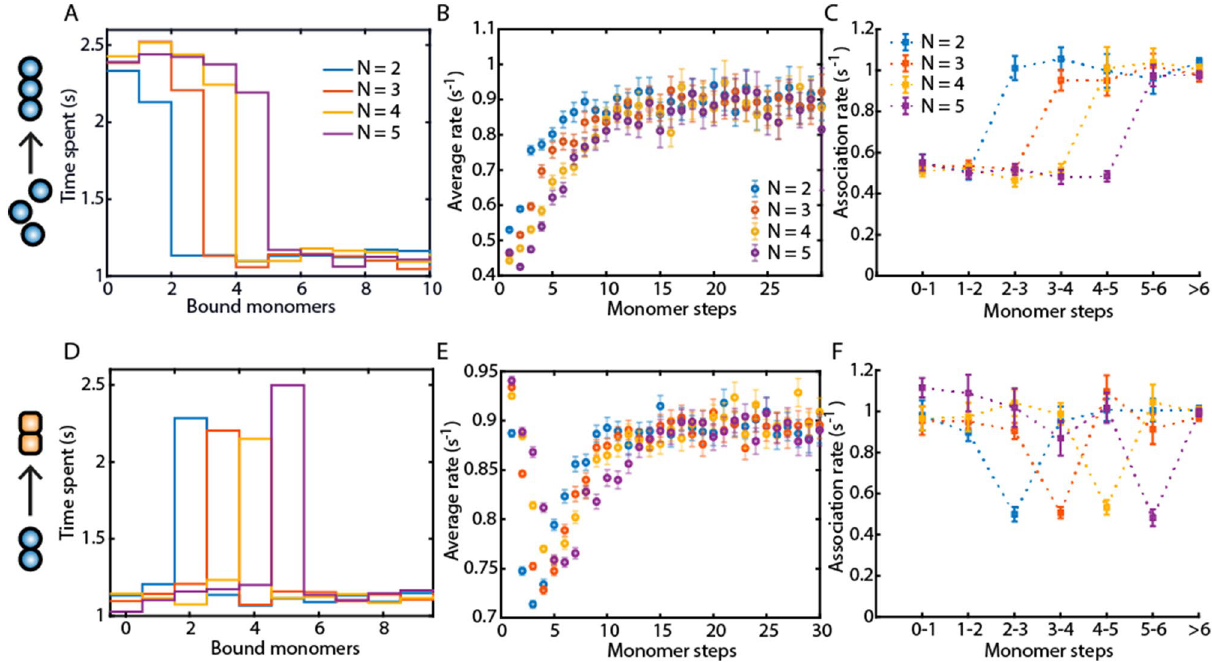
Figure 2. A comparison of the visitation analysis, average rates and dwell-time analysis on an assembly process with nucleus or conversion step with a size of 2, 3, 4 or 5 monomers. ( A , D ): A visitation analysis on a nucleation ( A ) and on a conversion mechanism ( D ). ( B , E ): Average rate analysis on the same nucleation ( B ) and conversion mechanism ( E ) as in ( A , D ) . ( C , F ): Dwell-time analysis on the same nucleation and conversion mechanism as in ( A , D ). The dwell-time analysis can identify a mechanism with a change in the on-rate by extracting the association rates ( C, F ), but not a mechanism with a change in the off-rate, since the extracted dissociation rates do not indicate any changes in the simulated rates (see Fig. S2). Error bars for the rates represent the 95% confidence intervals of the exponential fits. The association rates during nucleation k + nuc or the conversion step k + conv were chosen to be 50% of k + poly with no change in the